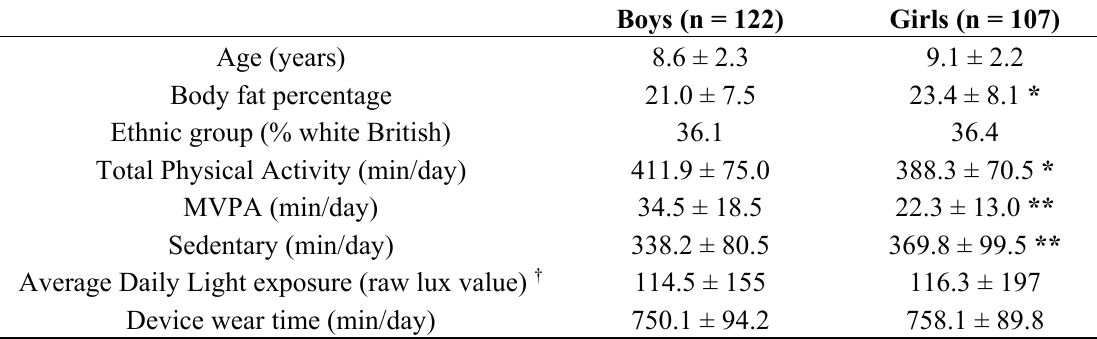
Table 1. Descriptive characteristics of participants stratified by